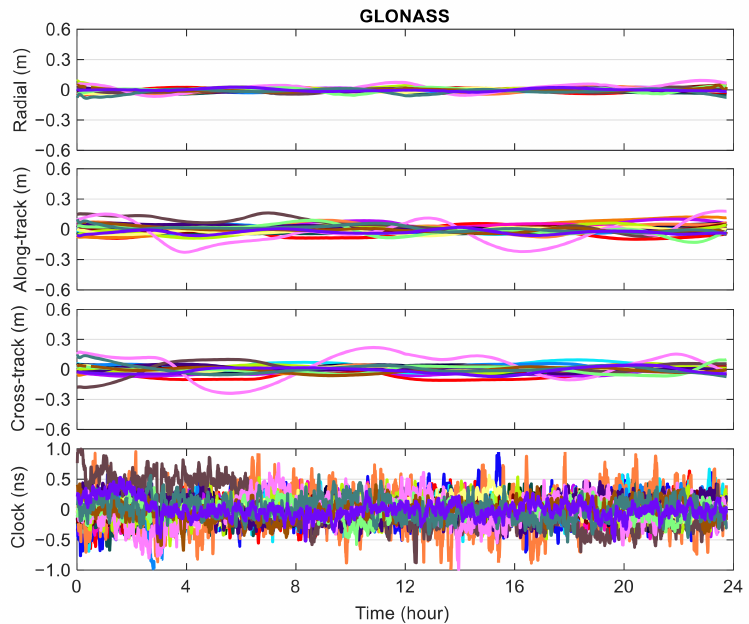
Figure 4. Epoch-wise orbit and clock differences for GLONASS satellites between GFZ and WHU precise products on DOY 122 of